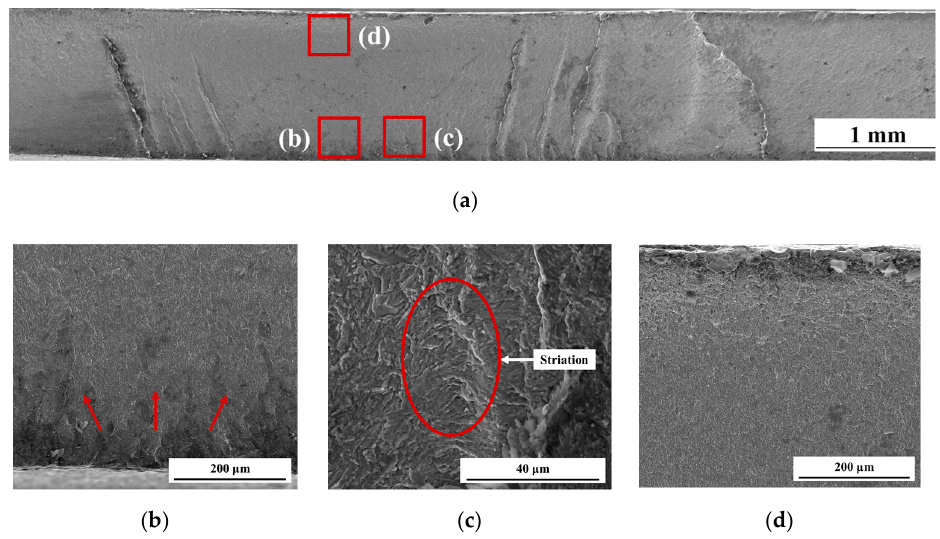
Figure 13. Fatigue fracture surface at HAZ mode: ( a ) overall view, ( b ) crack initiation area, ( c ) occurrence area of striation, and ( d ) crack propagation